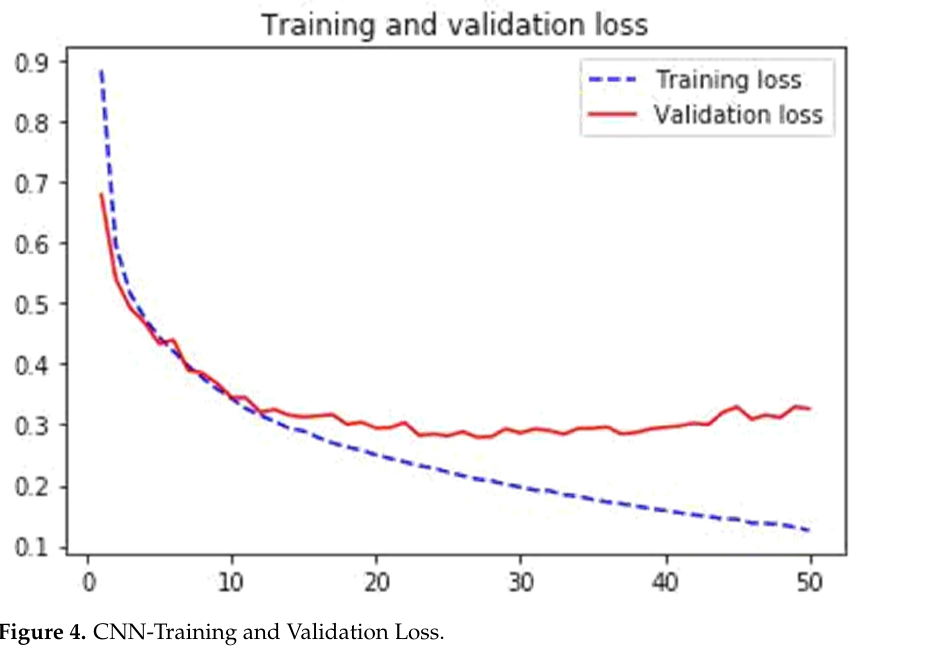
Figure 4. CNN-Training and Validation Loss. Algorithm 4 Multinomial Logistic Regression